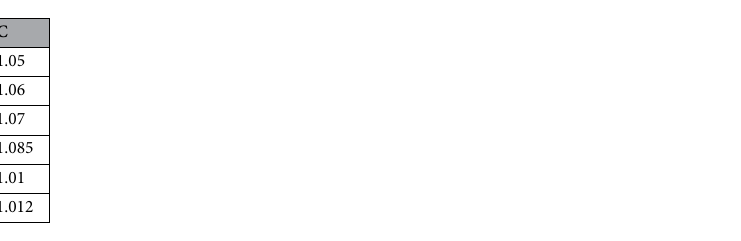
Table 2. Transition region empirical parameters for SCLC model in